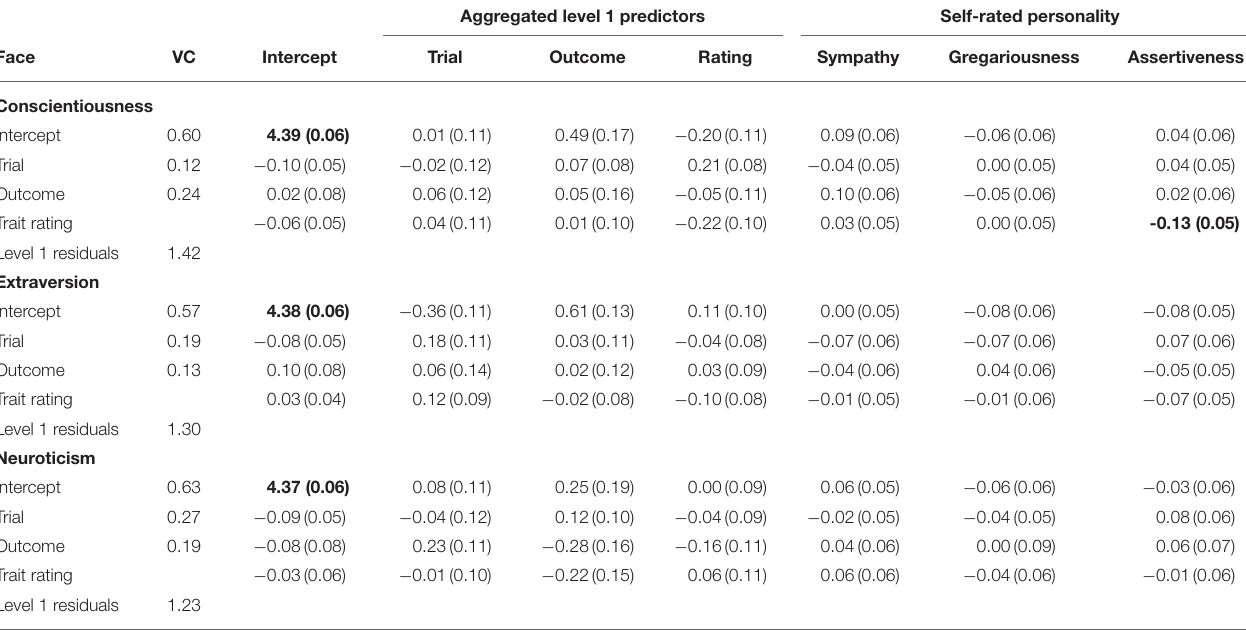
TABLE 2 | Coefficients (robust standard errors) for fixed effects of offered amount in the ultimatum